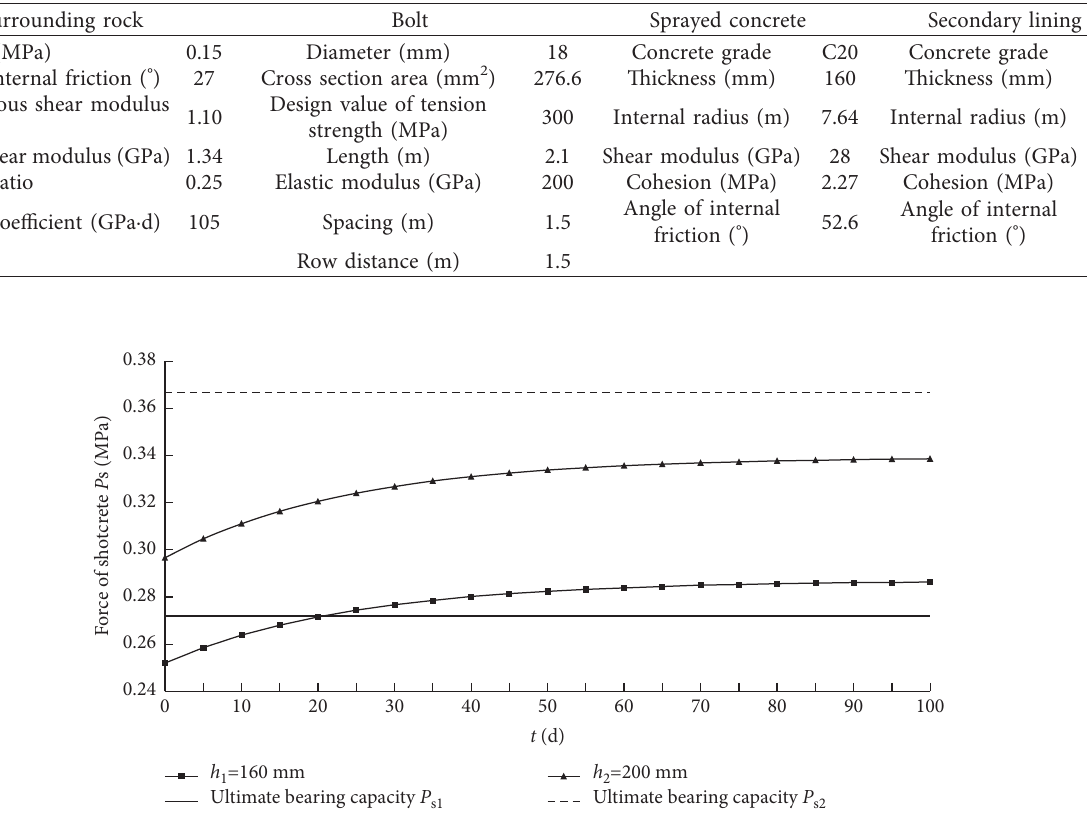
Figure 4: Radial force variation of shotcrete with